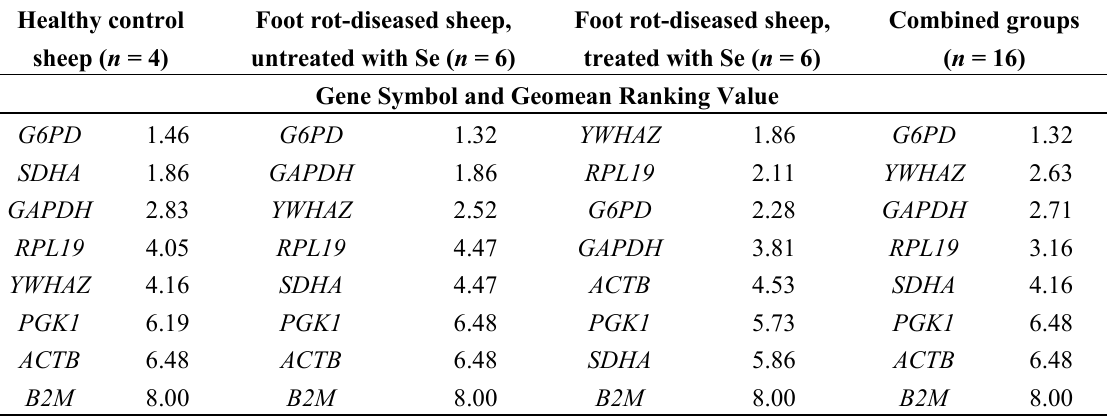
Table 7. Stability ranking of candidate reference genes in healthy control and foot rot-affected sheep, with or without selenium (Se) treatment, and in combined groups, by the geomean of ranking values for geNorm, NormFinder, BestKeeper and the comparative delta Cq method (lower geomean values indicate more stable gene